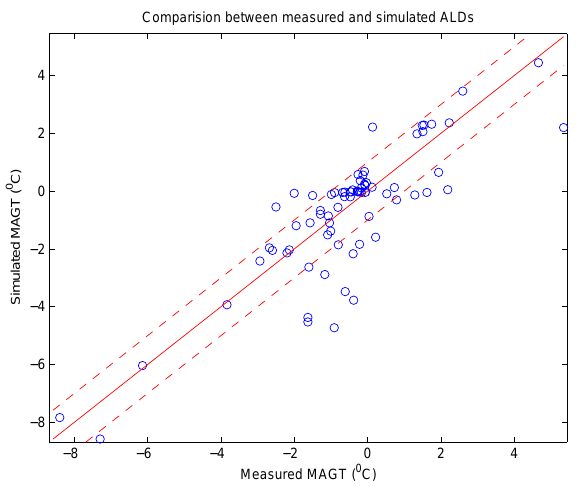
Fig. 6. Simulated and measured MAGTs from 1 to 6m depths during 2009.